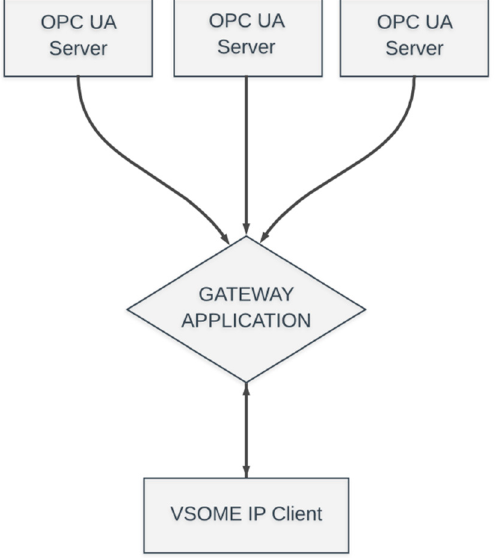
Figure 3. Second case study with the gateway accessing three different OPC UA Servers.